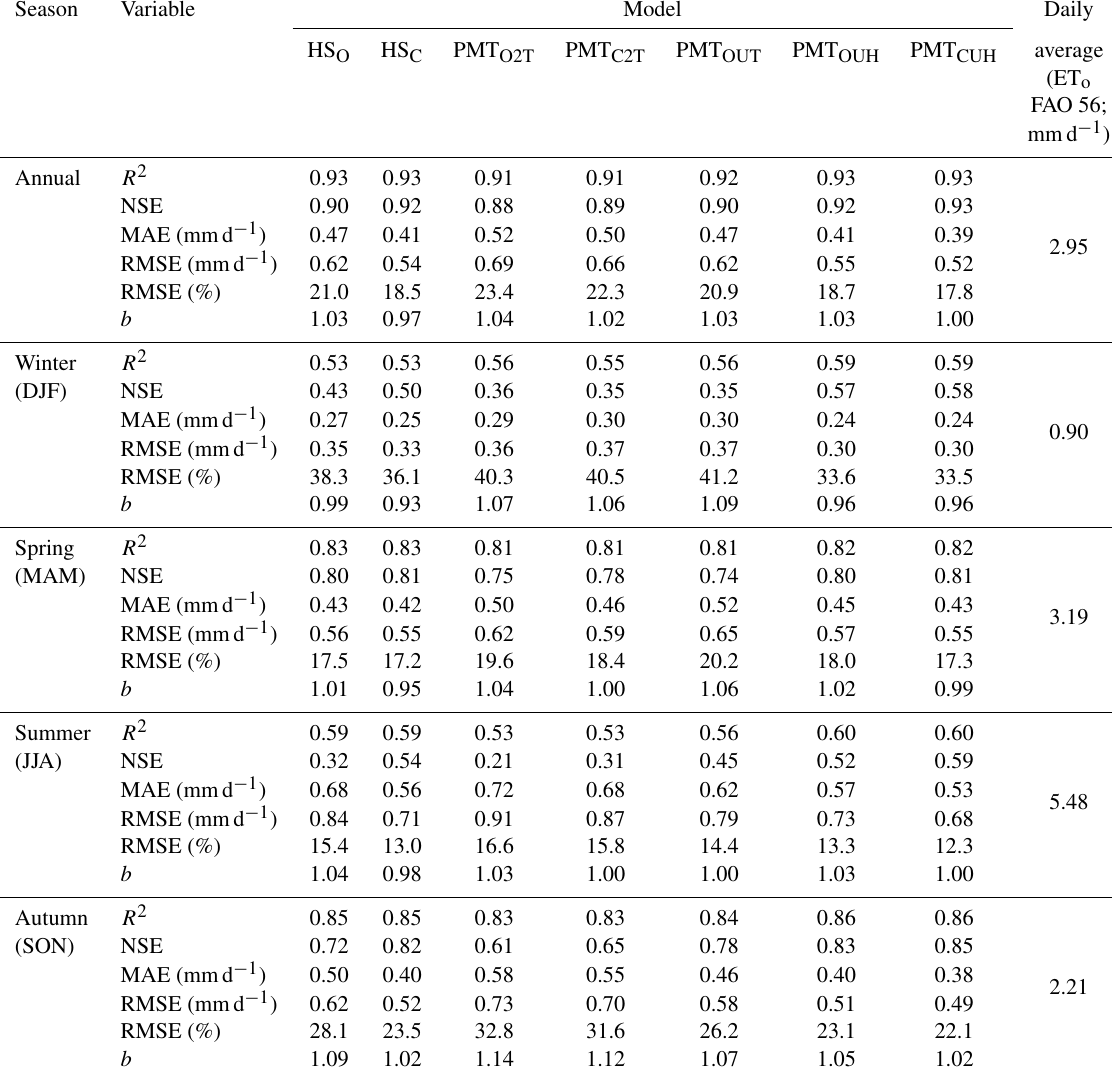
(ET o FAO 56; mmd − 1 )